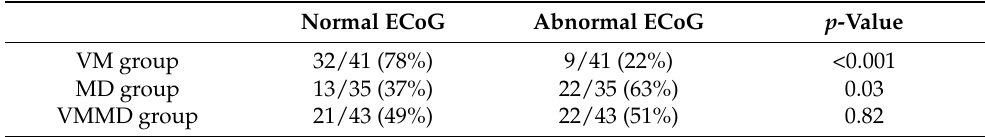
Table 4. Clinical criteria versus ECoG SP/AP AUC ratio for prediction of vestibular symptom improvement.